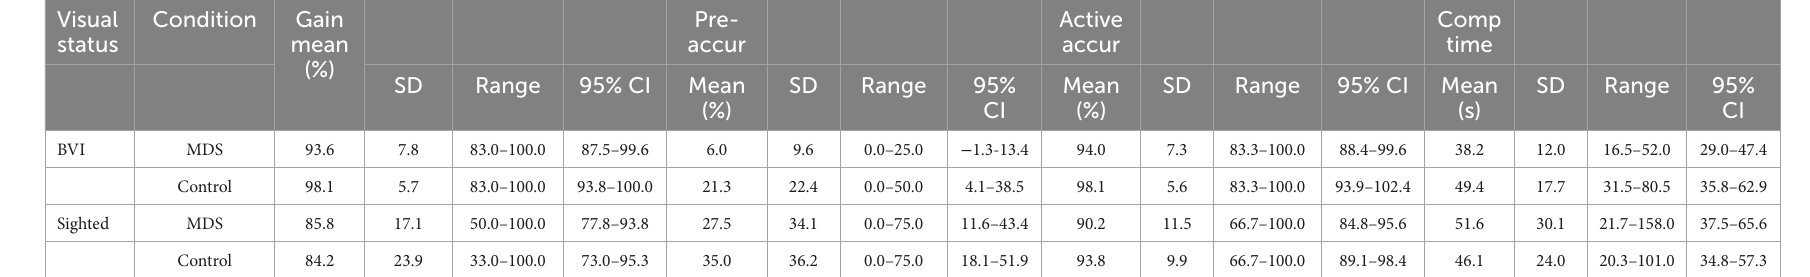
TABLE 5 Pre/post accuracy collapsed across